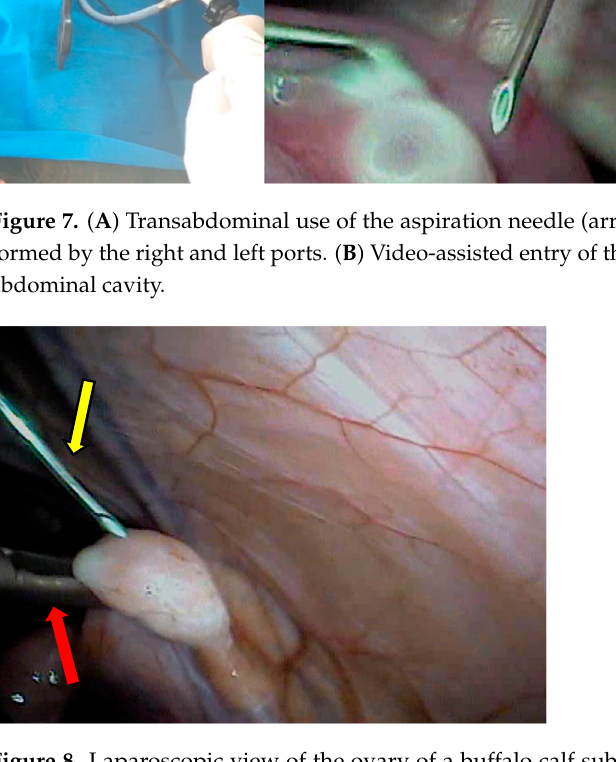
Figure 8. Laparoscopic view of the ovary of a buffalo calf submitted to follicular aspiration. Red arrow, atraumatic forceps; yellow arrow, aspiration needle.